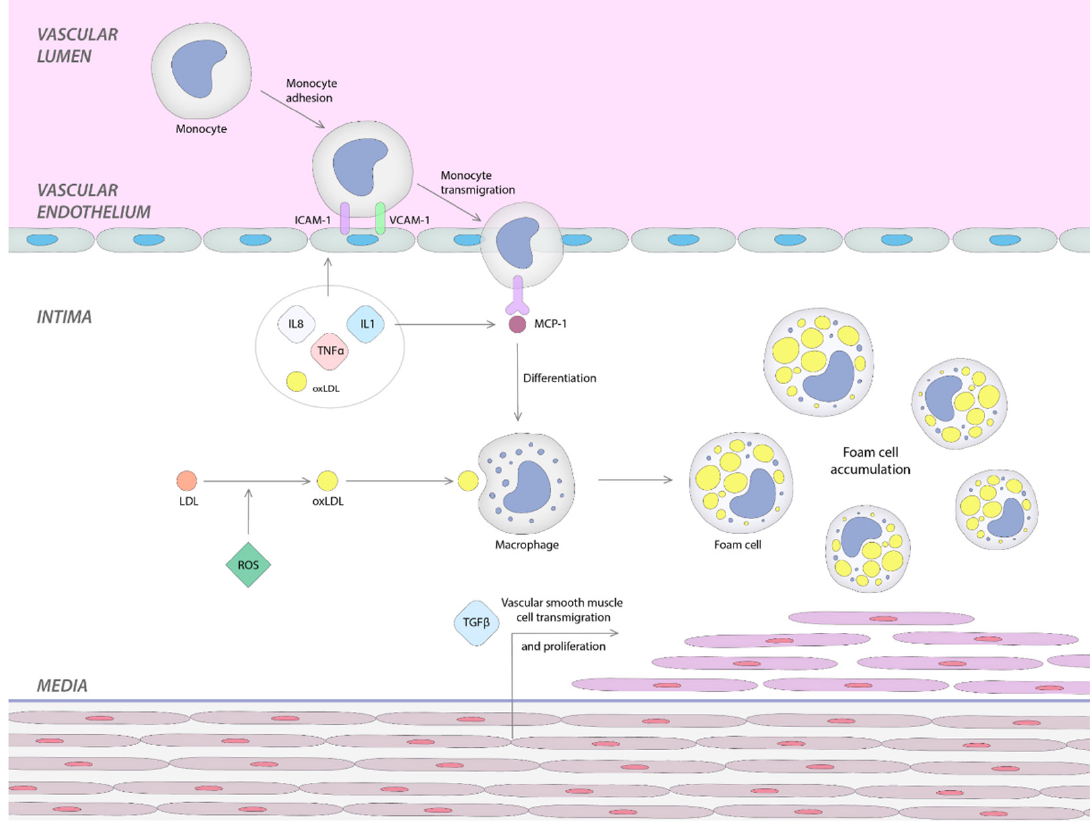
Figure 1. Stages of atherosclerosis mechanism in SLE patients.